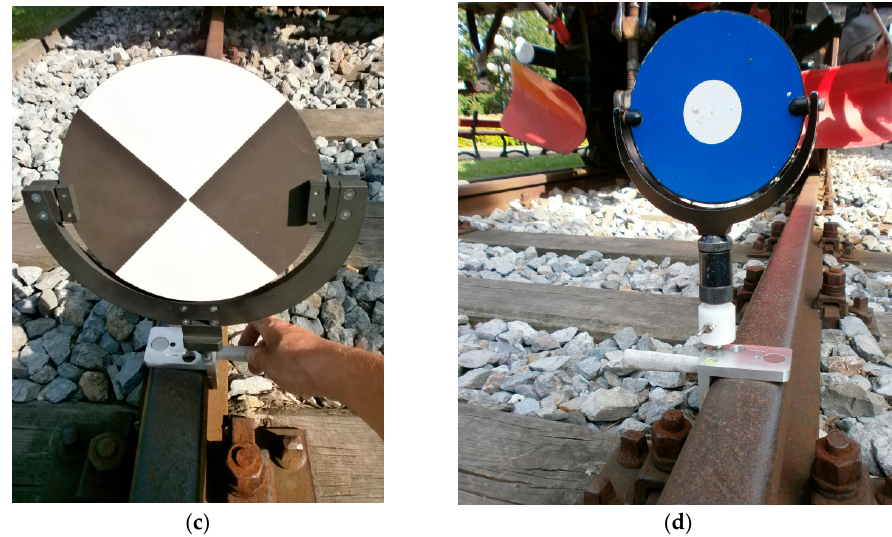
Figure 1. Application of the proprietary Magnetic-Measuring Square (MMS) in monitoring infrastructure of rail transport (own figure and photograph): ( a ) MMS in the cross section built on the rail head (crown of the rail); ( b ) MMS with Geodetic Mini Prism Type 111 (GMP111); ( c ) MMS with High-Definition Surveying (HDS) flat target Black & White and proprietary adapter made of insulating material for assembling reference signals to scanners; ( d ) MMS with HDS flat target Blue & White and proprietary adapter made of insulating material for assembling reference signals to scanners.